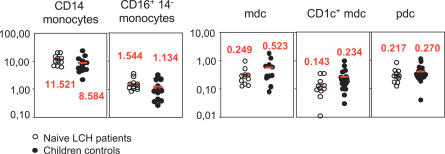
Putative LC Precursors are Detected at Normal Frequencies in the Peripheral Blood of Naïve LCH PatientsCD14+ monocytes (DR+, CD14+, CD16lo) and CD16+ monocytes (DR+, CD14−, CD16hi), MDCs (DR+, CD11c+, lin−), CD1c+ MDCs (DR+, CD1c+, CD11c+, lin−), and PDCs (DR+, BDCA-2+, CD123+) from naïve (untreated) LCH patients and age-matched control children were studied by five-color flow cytometry. Data are represented as the percentage of PBMCs. p-Values (Kruskal-Wallis test) for the comparison between naïve (untreated) LCH patients and age-matched control children were not significant either in the number or in the frequency of DC and monocyte subsets present in the peripheral blood.